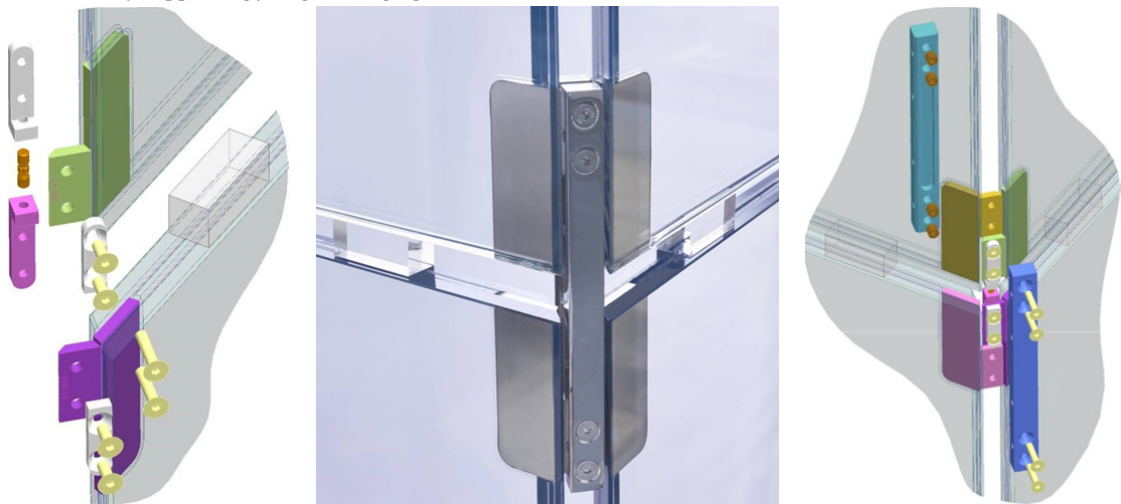
Fig. 9 Edge connection between four façade panels,